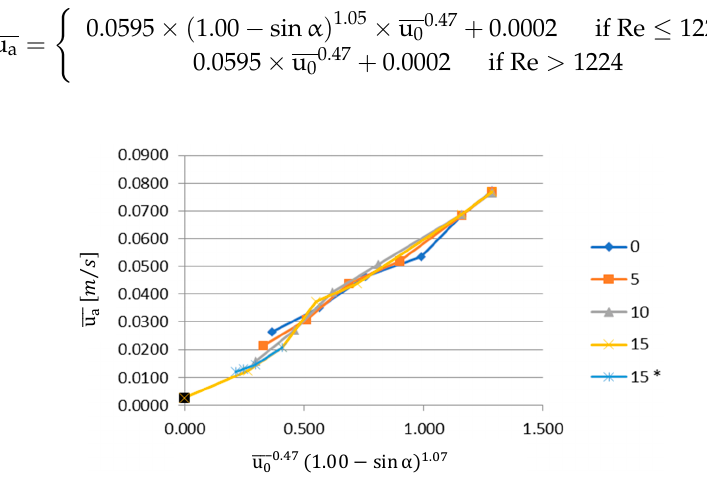
Figure 11. Relation between the average velocity at the opening and u (cid:2868) (cid:3364)(cid:3364)(cid:3364) (cid:2868).(cid:2872)(cid:2875) (cid:4666)1.00 (cid:3398) sinα(cid:4667) (cid:2869).(cid:2868)(cid:2875) (15* values correspond to tests with variations in jet thickness).